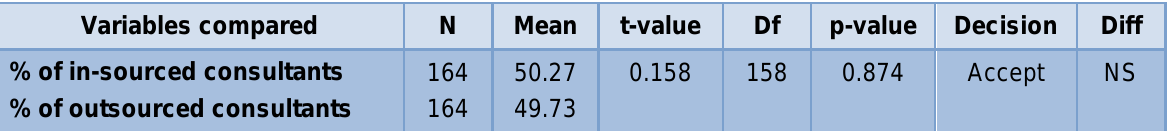
Table 3 Results of t-test for difference between the use of in and out sourced consultants N=Number of respondents, Df=Degrees of freedom. Diff=Difference, NS=Not